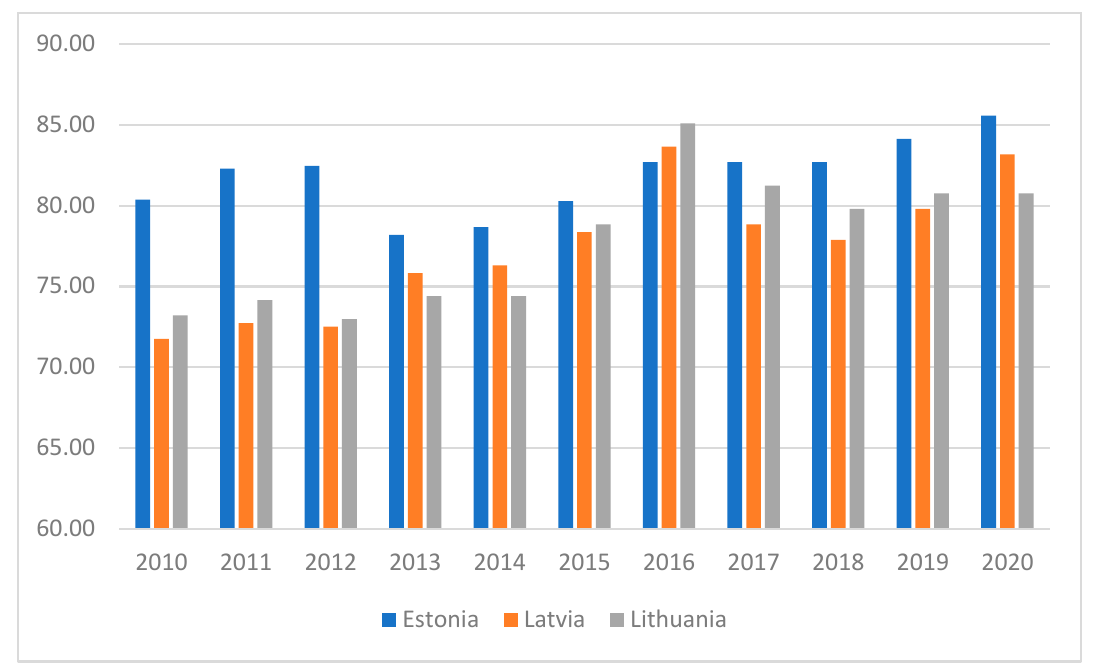
Figure 4. Government effectiveness dynamics in the Baltic states over the period 2010–2020. The fluctuations in the research and development expenditure indicator were similar in all three Baltic states during the period under consideration. The highest rates were recorded in Estonia, while the lowest—in Latvia (Figure 5).